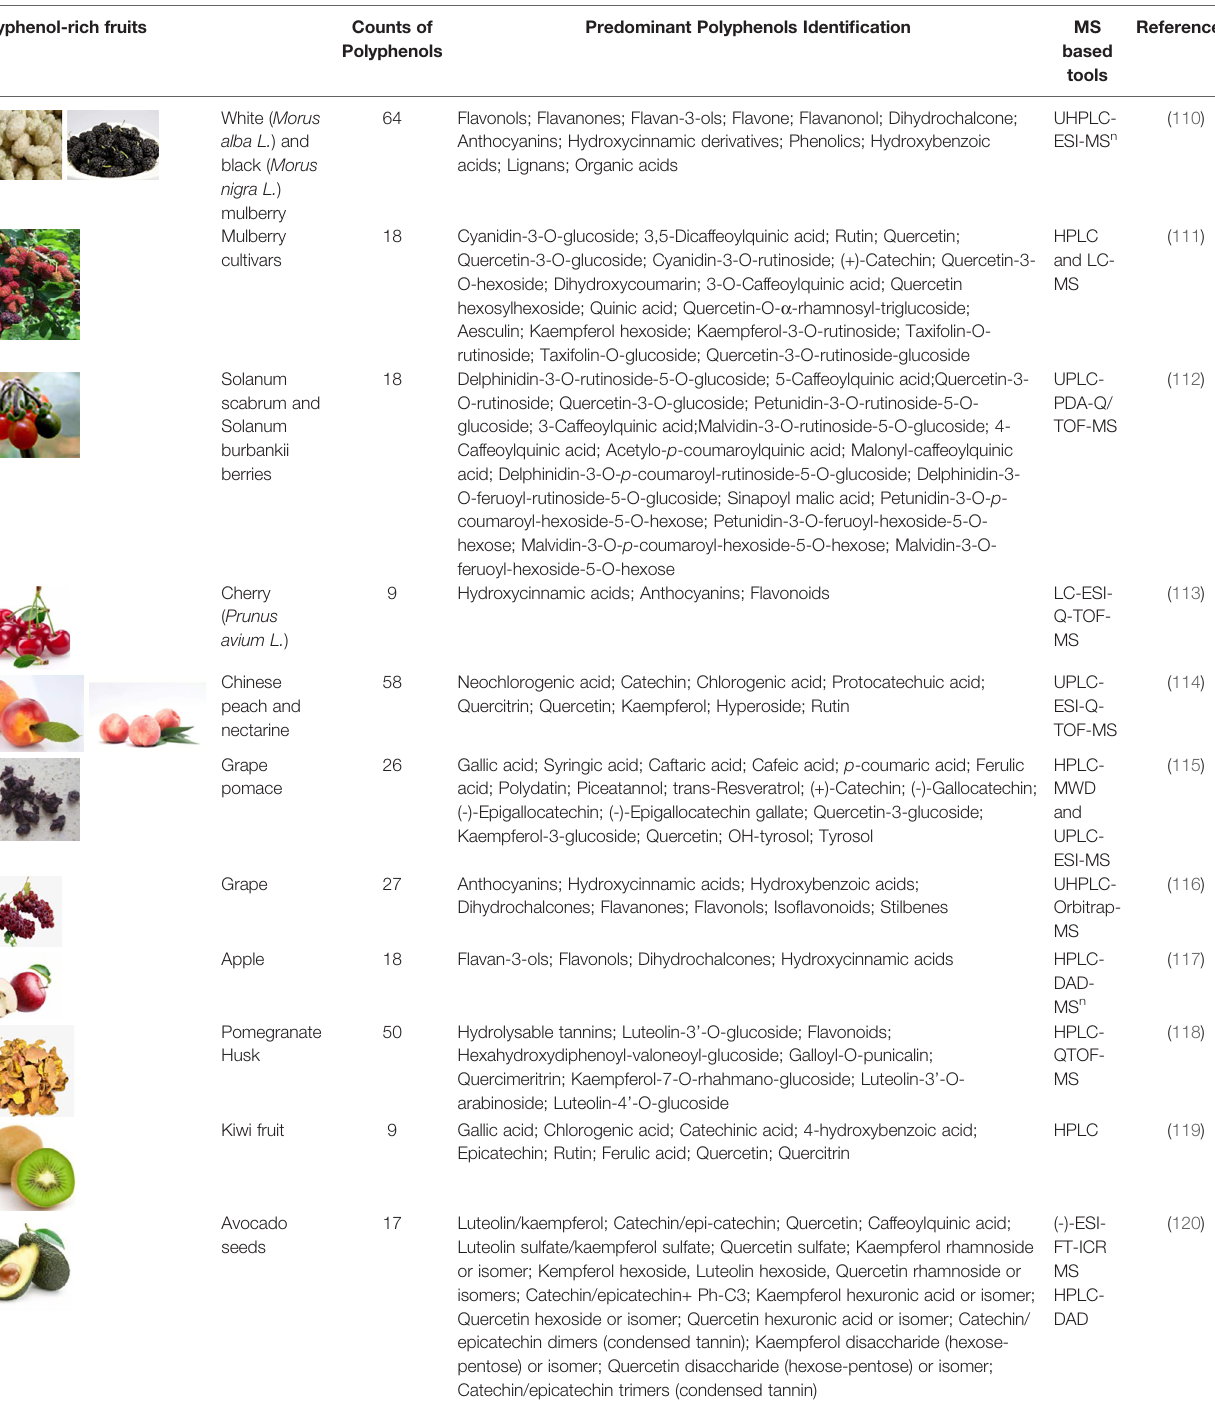
(DML) technology to quantitatively examine relative changes in the protein. Rosemary extract, which is rich in polyphenols protected intestinal health with anti-proliferative effects by inducing proteomic changes in cells of HT-29 colon cancer, reducing aggregates formation and stimulating autophagy.